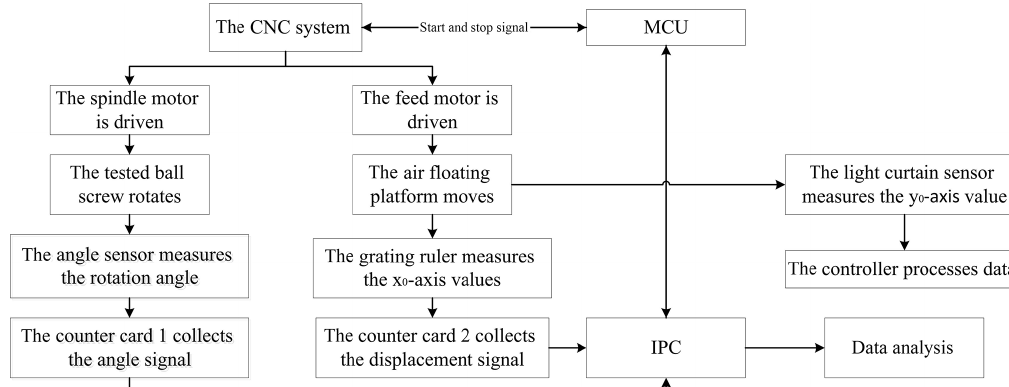
Figure 4. The measurement system.